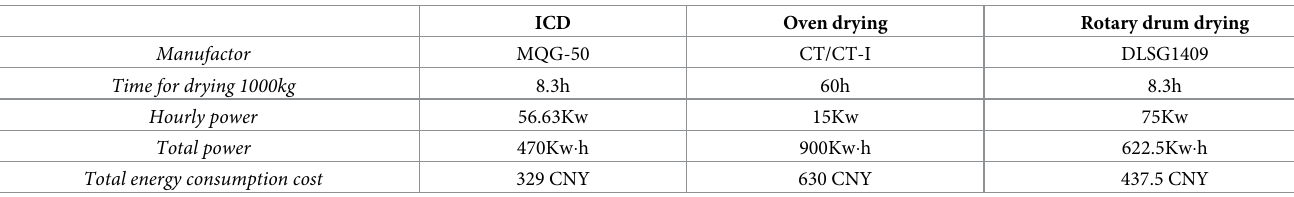
Table 4. Energy consumption cost of different drying